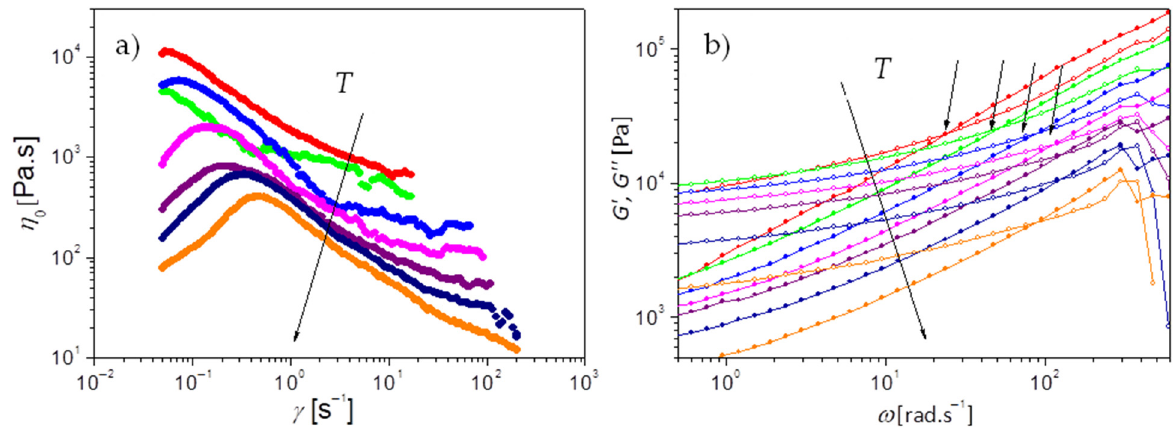
. γ , and ( b ) complex